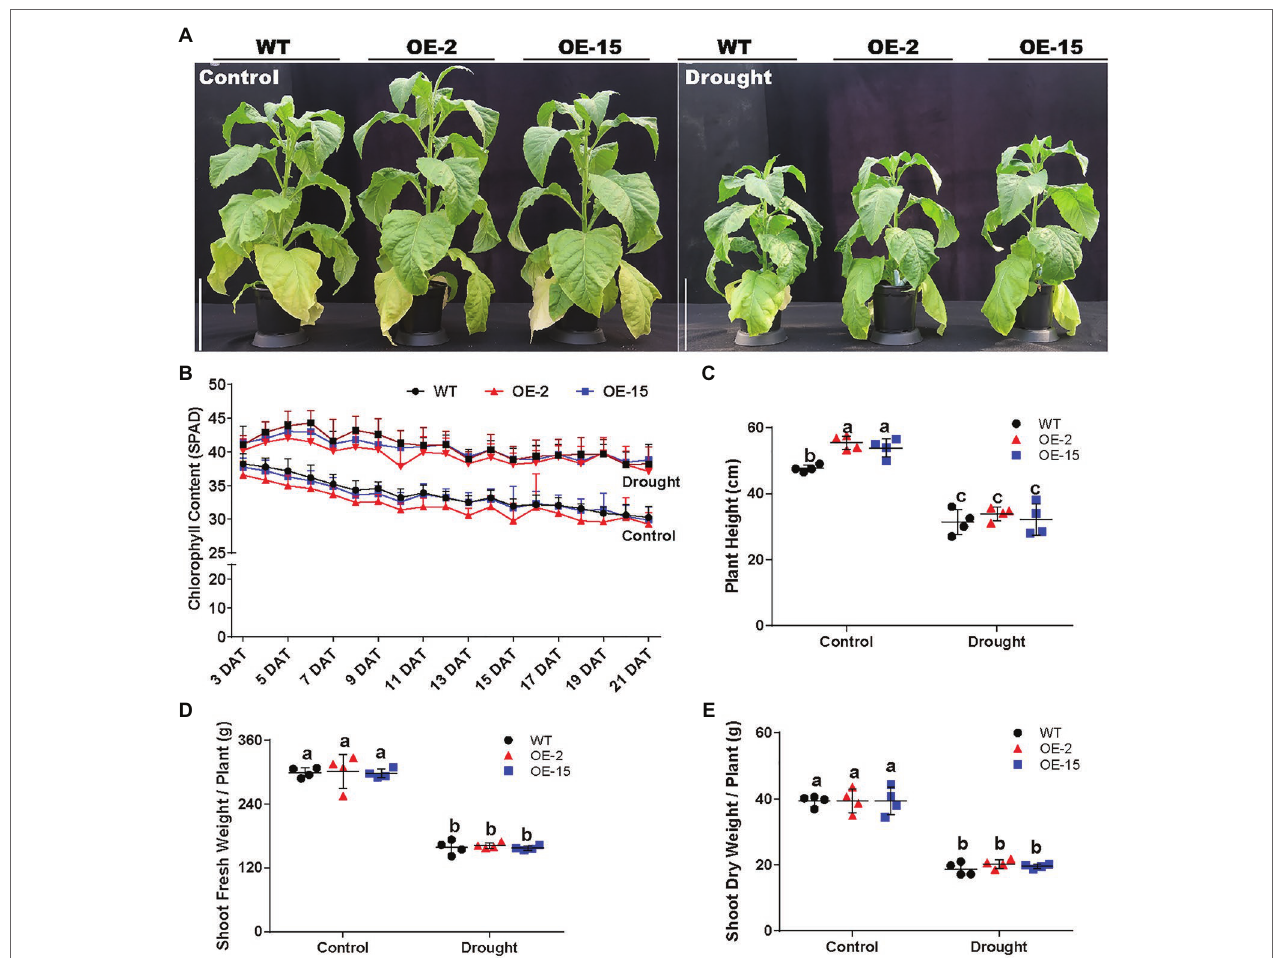
FIGURE 5 | Phenotypic analysis of WT and NtCBL5A -OE lines (OE-2 and OE-15) under control conditions and drought stress. Scale bars = 30 cm. (A) The phenotype of WT and NtCBL5A -OE lines under control conditions and drought stress at 21 DAT and 64 DAG. (B) The chlorophyll content of the eigth leaf of WT and NtCBL5A -OE lines from 3 to 21 DAT. (C–E) The plant height, fresh shoot biomass, and dry shoot biomass of WT and NtCBL5A -OE lines at 21 DAT. Error bars indicate ±SD ( n = 4), different letters above bars (a, b, and c) indicate significant statistical difference based on one-way ANOVA with LSD test ( p <